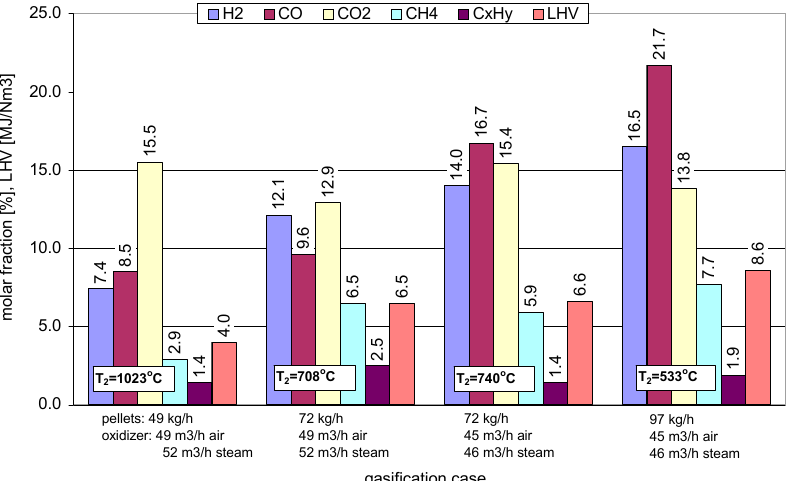
Figure 15. Composition of fuel gas and its LHV for different conditions of continuous HTAG with a preheated mixture of air and steam as the feed gas (experimental results).